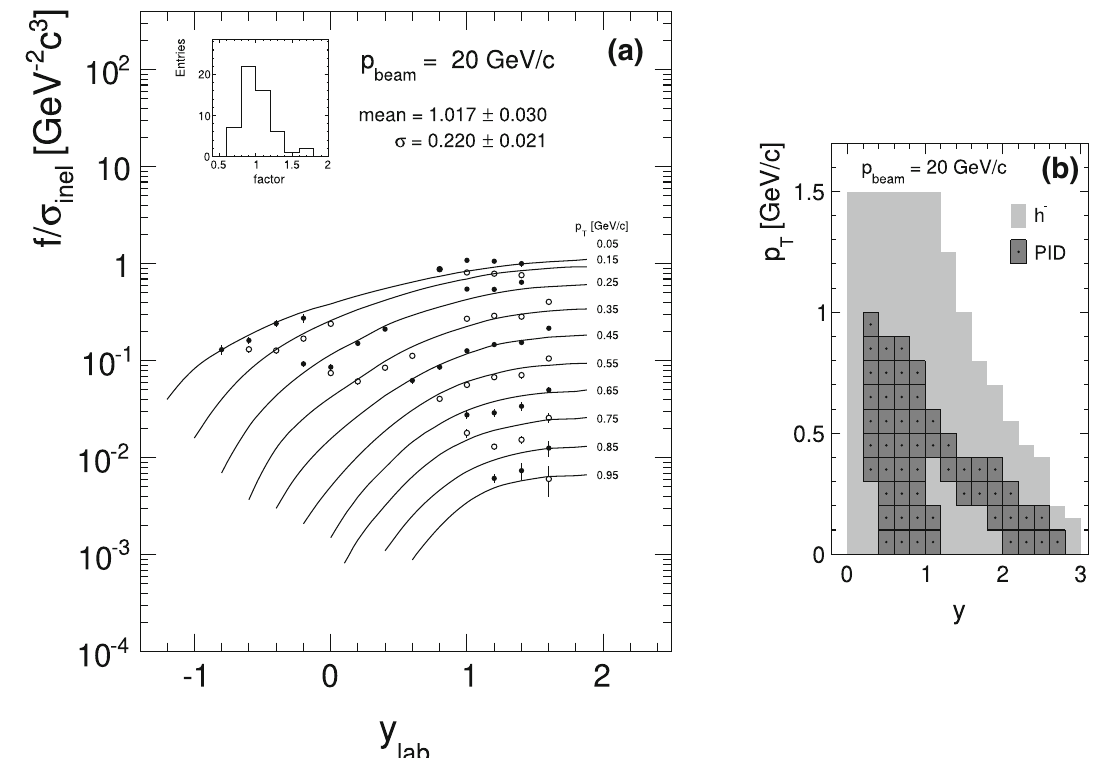
Fig. 69 a Cross sections f /σ inel [36] with particle identification as functions of p T and y lab compared to the interpolation of the NA61 h − data (full lines) for 20 GeV/c beam momentum; b coverage in the y / p T . The h- acceptance is shown in comparison as the light grey area